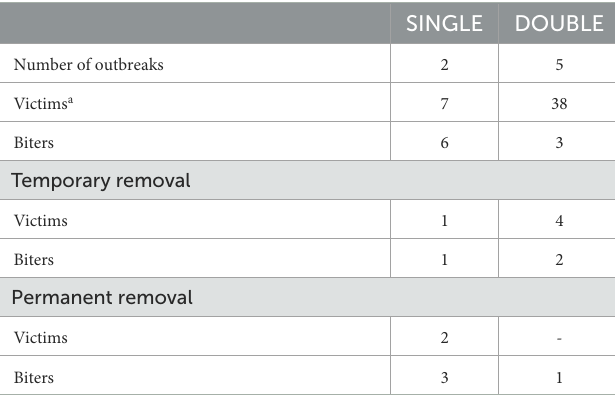
TABLE 3 Details of tail-biting outbreaks and severe tail damage (i.e., some level of tail amputation) during the experiment in each treatment,